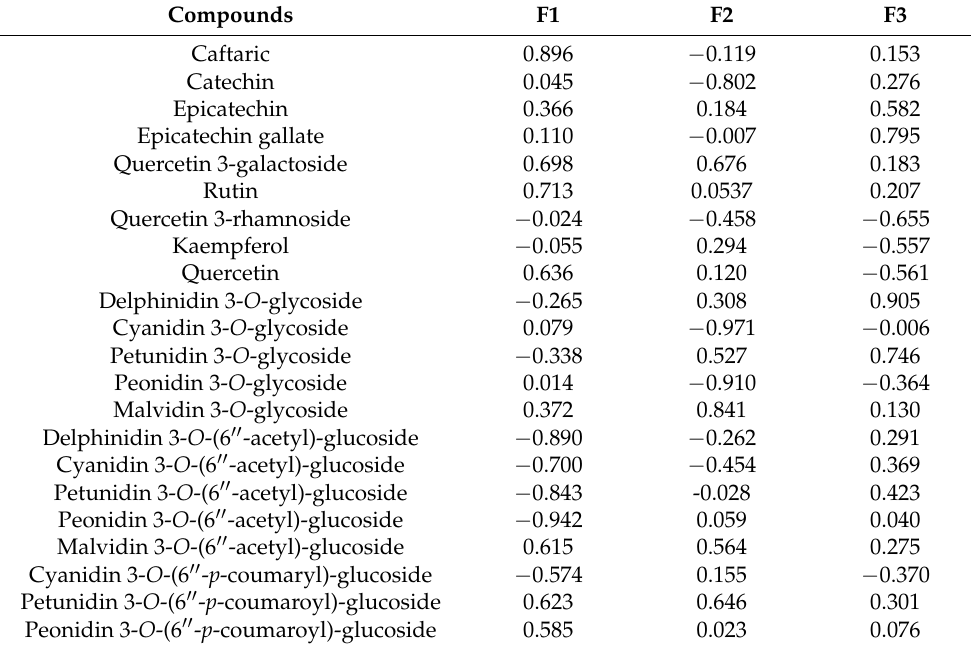
Table 3. Principal component loadings of phenolic compounds, including anthocyanins, in ‘Tintilla de Rota’ and ‘Graciano’